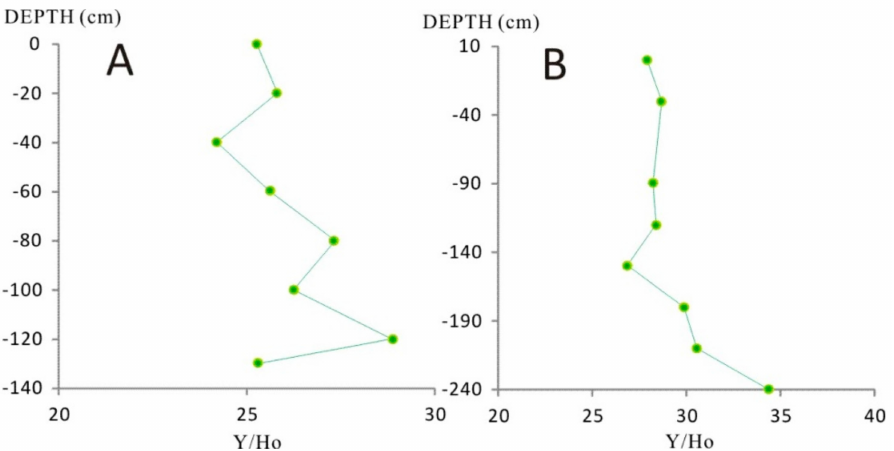
Figure 8. Variation of Y / Ho ratio with the depth in the ( A ) SC and ( B ) TG profiles. The soil layers were the same as described in Figure 7 and Table